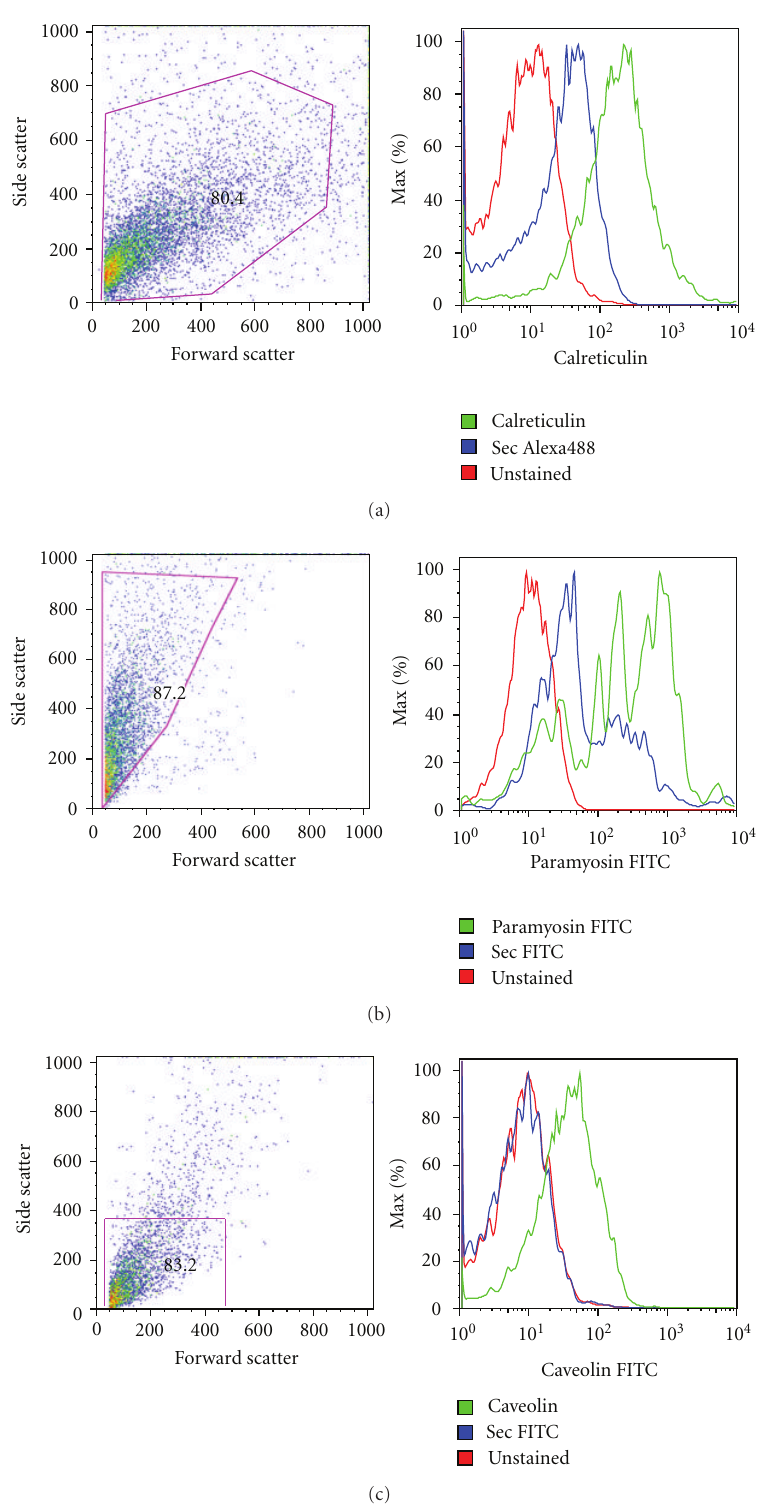
Figure 5: Expression of parasite-specific proteins on (a) T. solium, (b) T. crassiceps, and (c) T. spiralis . Anticalreticulin and antiparamyosin antibodies were obtained by mice immunization with cloned and expressed proteins from T. solium and T. crassiceps . Anticaveolin antibodies were obtained by mice immunization with a cloned and expressed protein from T. spiralis